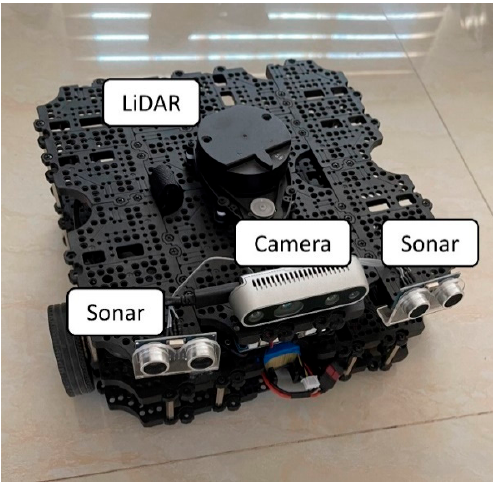
Figure 6. Sensor’s physical placement on Turtlebot 3 Waffle